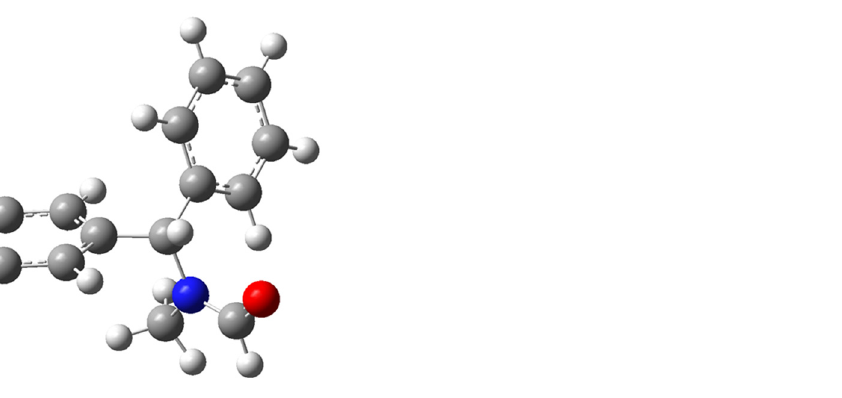
Figure 4. Conformation of BHFA-NMe molecule, which has the lowest energy according to the DFT calculation in the M06-2X/6-311+G*/IEFPCM(DMSO) approximation.